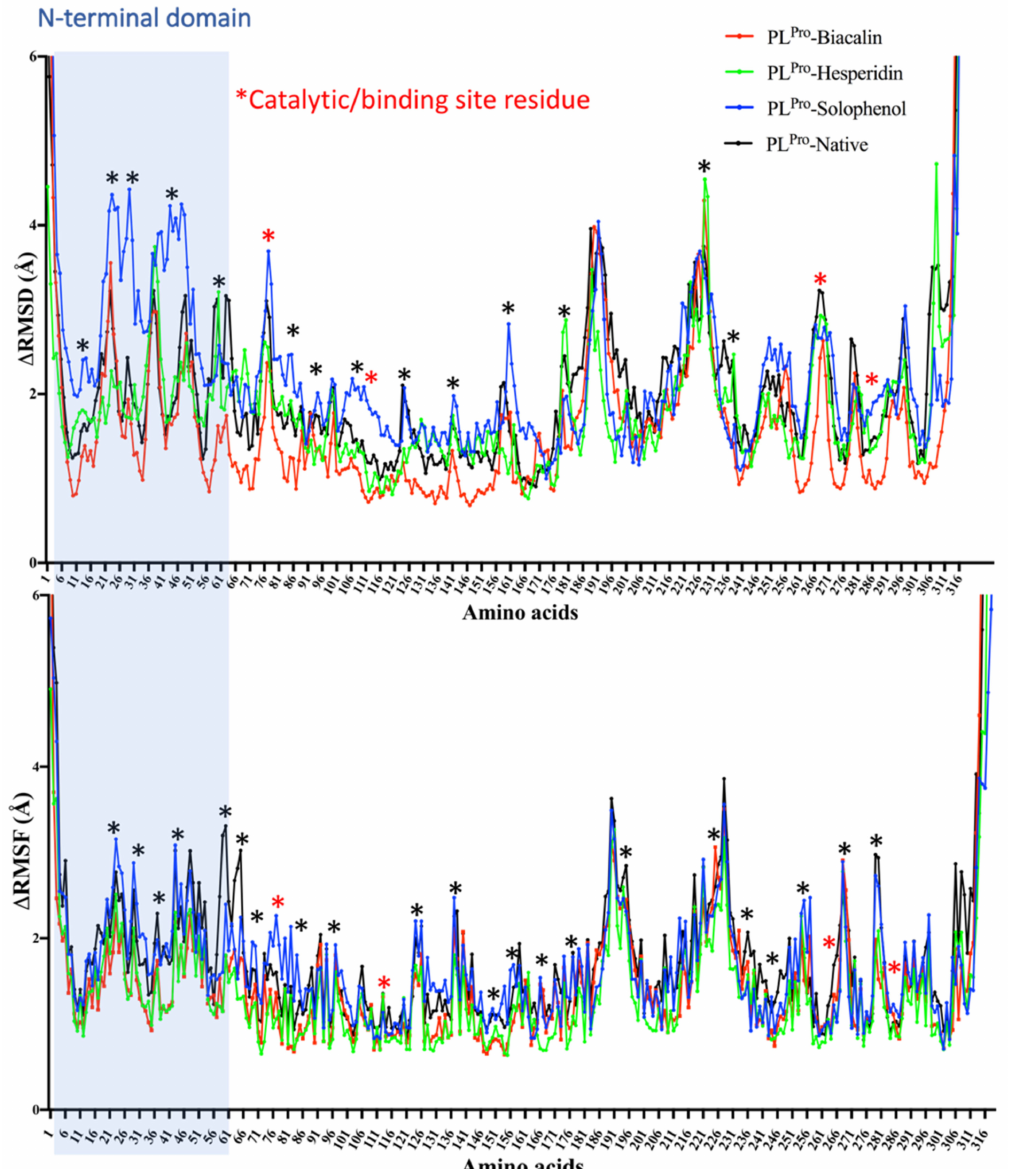
Figure 5. RMSD and RMSF calculated from a 30 ns molecular dynamics simulation of Baicalin (red), Hesperidin (green), and Solophenol (blue) docked with SARS-CoV-2 PL pro . The residues with dynamic RMSD and RMSF are mentioned with ‘*’ while red ‘*’ shows the active site